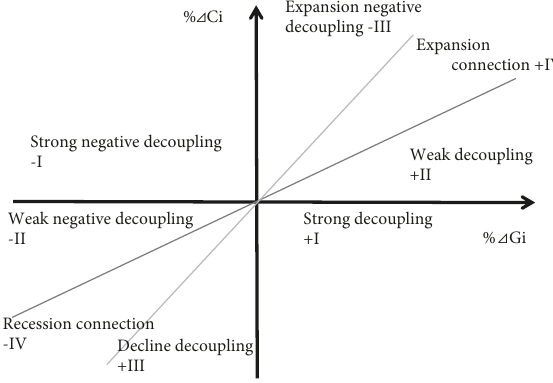
Figure 1: Framework for decoupling